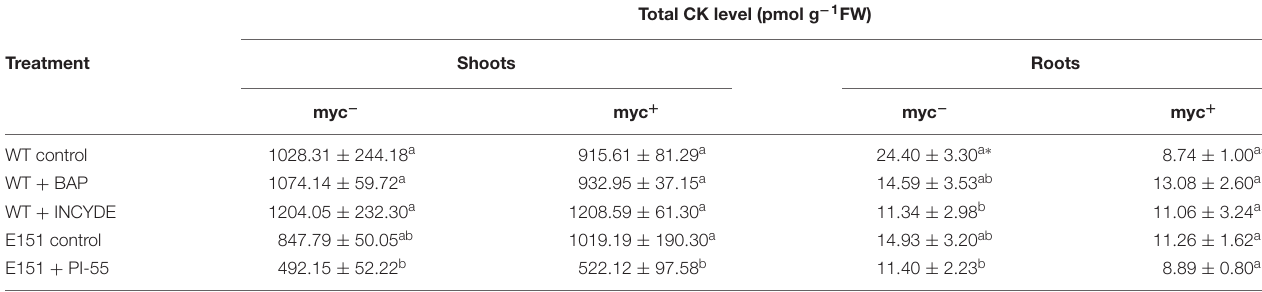
TABLE 1 | Levels [pmol g − 1 of fresh weight (FW)] of total CK isolated from shoots and roots of non-mycorrhizal (myc − ) and mycorrhizal (myc + ) pea plants.